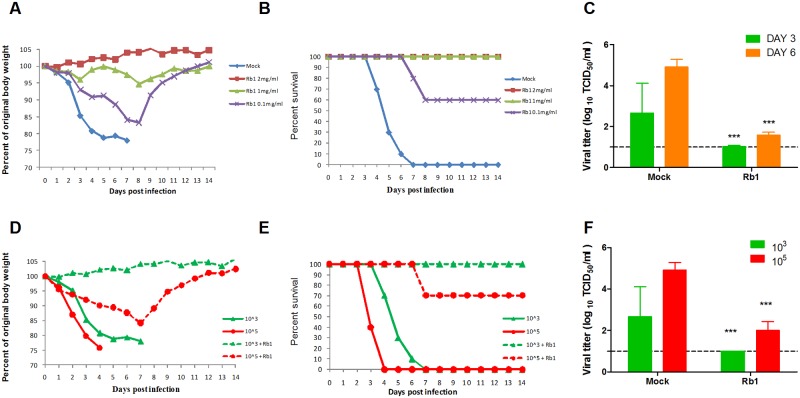
Dose dependent antiviral activity of ginsenoside Rb1.Balb/c mice (n = 10/group) were infected with 103EID50 of A/Nanchang/8002/2009 (H1N1) pre-incubated with varying concentration of Rb1. Significant changes in (A) animal weight and (B) survival rate was observed in these group compared to mock (untreated) group. (C) MDCK cells were used to titrate viral loads present in lung tissues of Rb1(2mg/ml) treated and untreated animals at 3 and 6 dpi. (D-E) Mice (n = 10/group) were infected with different viral inoculum pre-incubated with 2mg/ml of Rb1. (D) changes in animal weight and (E) survival was observed in these group. (F) lung viral loads were titrated on 3 dpi (n = 3/group). Results were expressed as log10 values of the mean of viral load ± SEM. *** P < 0.0005.